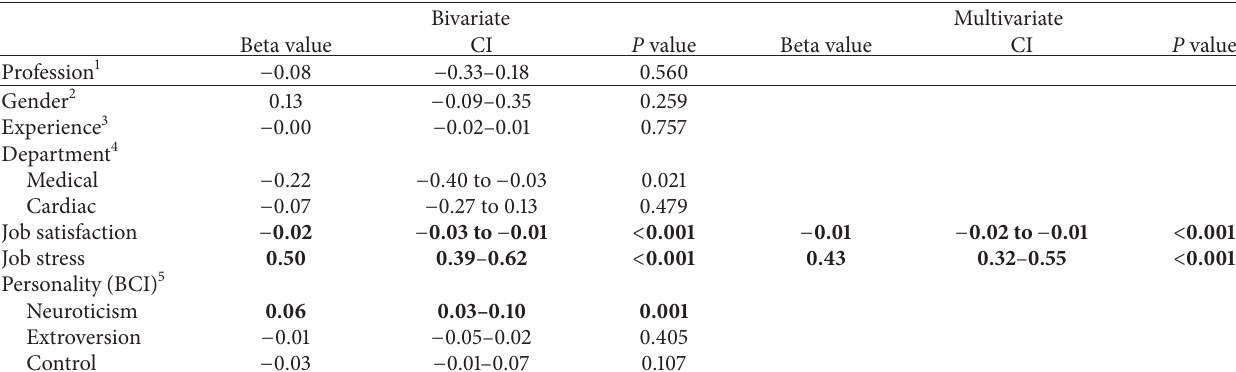
Table 4: Predictors of the burnout dimension emotional